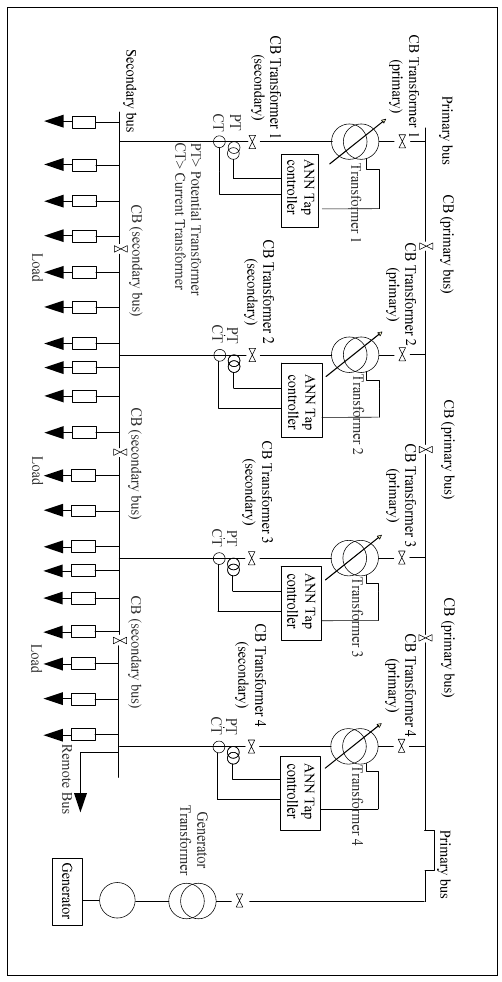
Fig. 2: Single line diagram of four transformers in substation with ANN based tap changing controller For implementation in a hardware system